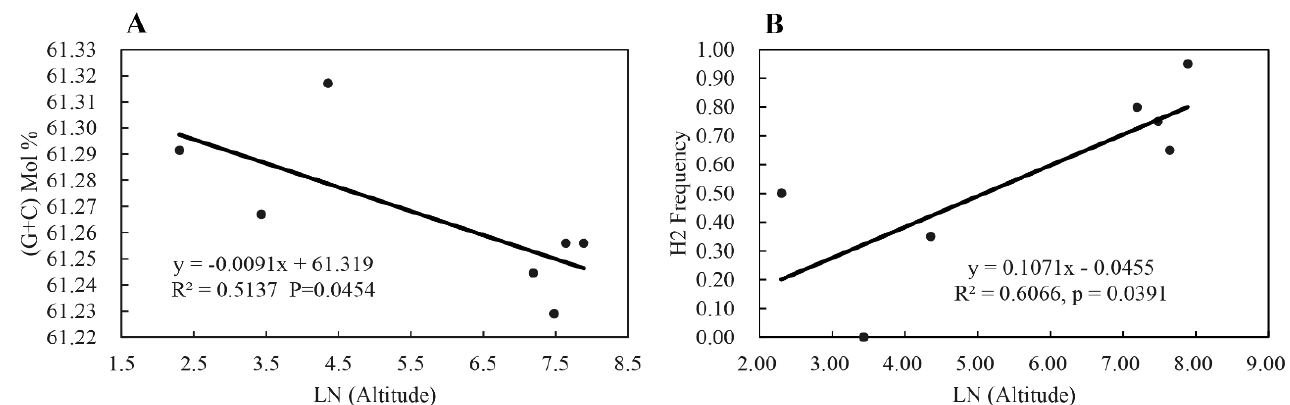
Figure 4. Correlation between natural logarithm transformation of altitude (m) in the collection sites and sequence characteristics (i.e., ( A ) GC content and ( B ) frequency of the dominant haplotype) of the RAD23 gene in the seven Phytophthora infestans populations sampled from China.